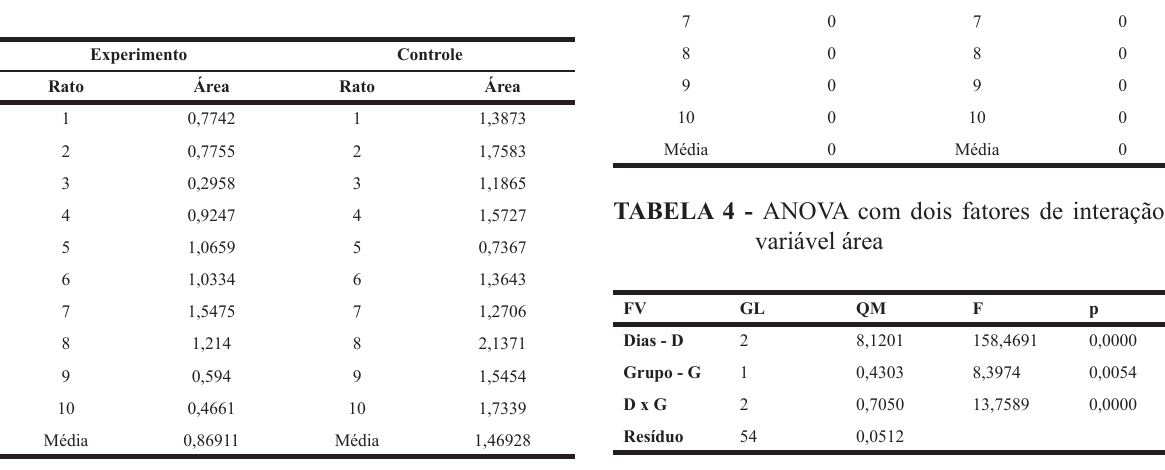
TABELA 1 - Planimetria do grupo experimento e controle de 7 dias.